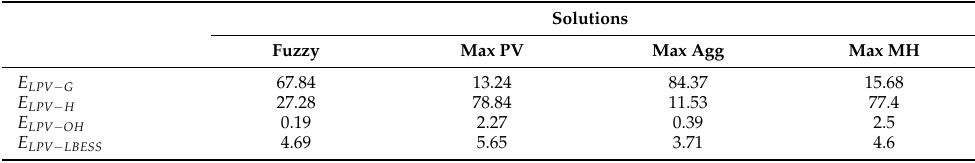
Table 11. Numerical values (in %) associated with Figure